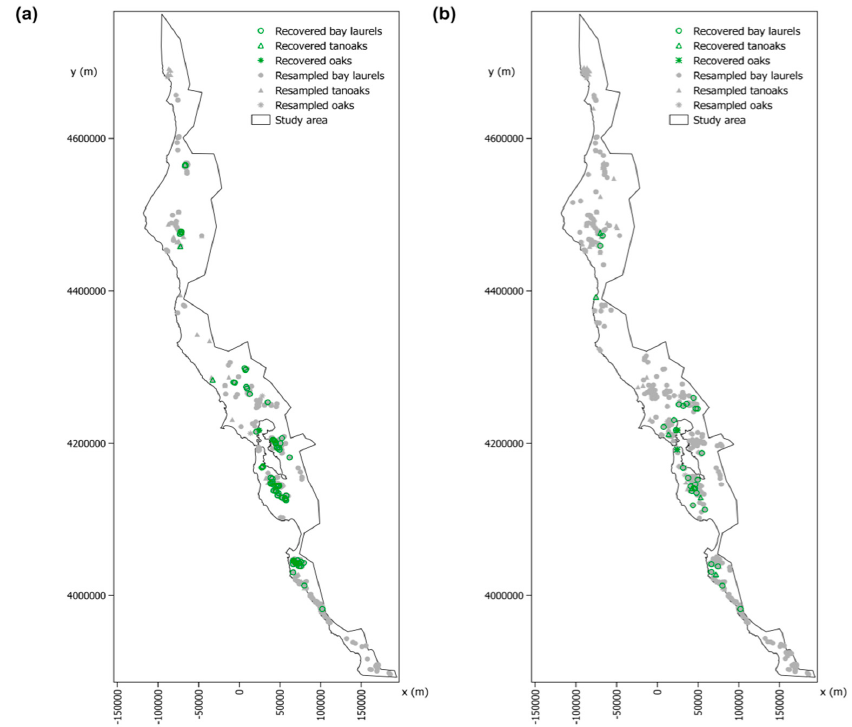
Figure 3. Distribution of resampled and recovered bay laurels, tanoaks and oaks in scenario-10 m ( a ) and scenario-500 m ( b ). Coordinates are in UTM NAD83 zone 11N (EPSG 4326). Table 1. Trees recovered from P. ramorum infections.